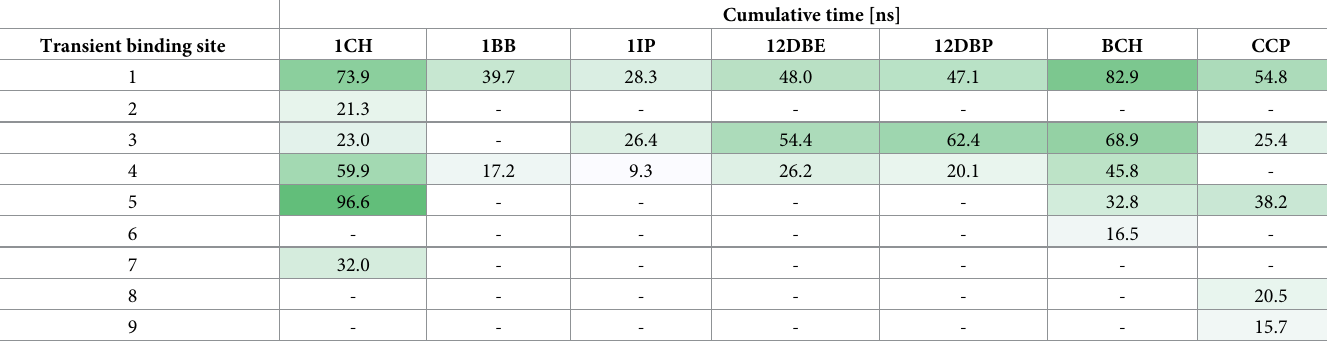
Table 1. Cumulative time of the measured interactions of particular substrates with transient binding